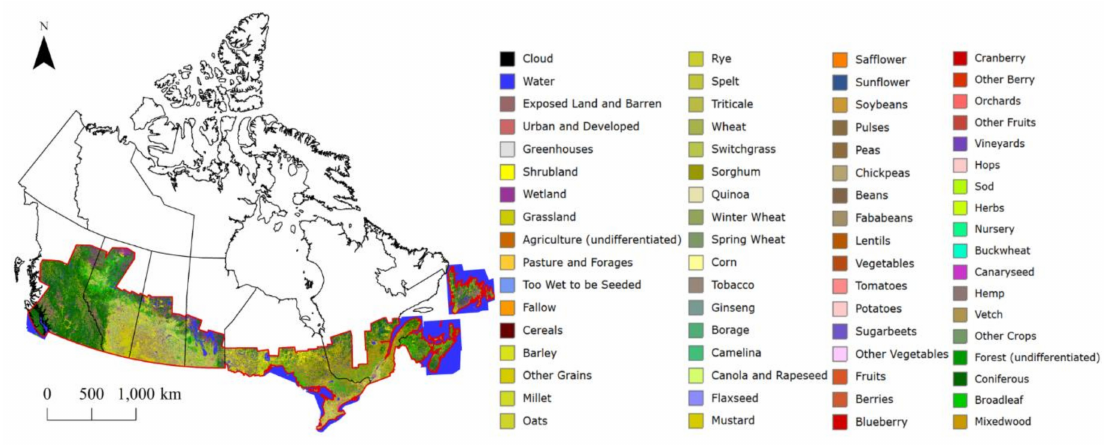
Figure 1. Annual Space-based Crop Inventory (ACI) produced by Agriculture and Agri-Food Canada (AAFC) in